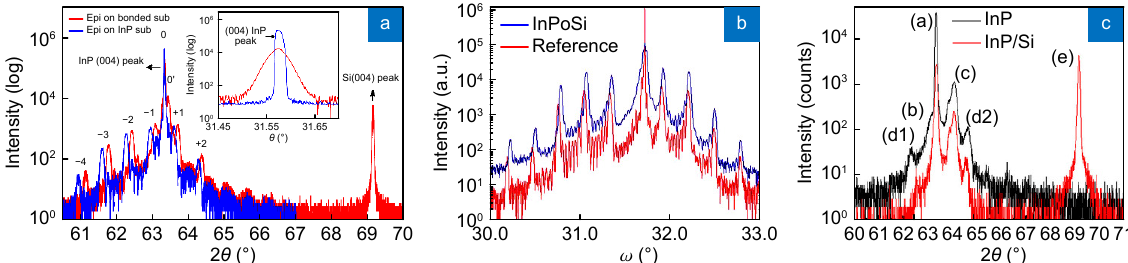
Fig. 8 | XRD measurements on the epitaxy samples that from the three different research groups. Figure repoduced with permisson